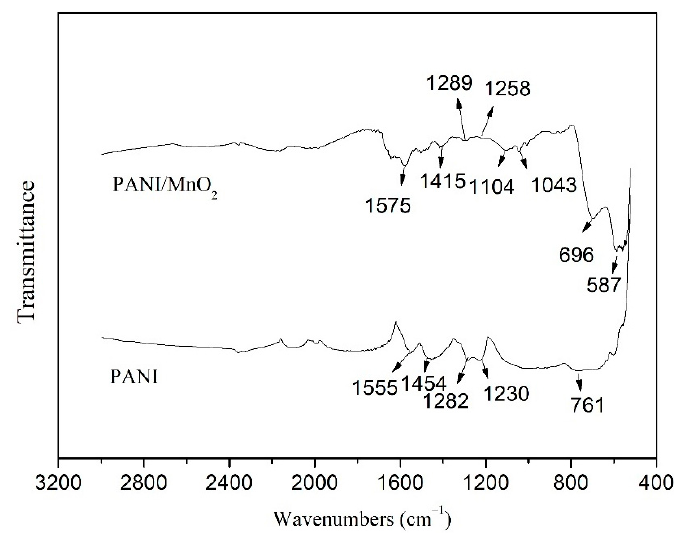
Figure 4. Fourier transform infrared transmission spectra of PANI and PANI/MnO 2 composite (C2).